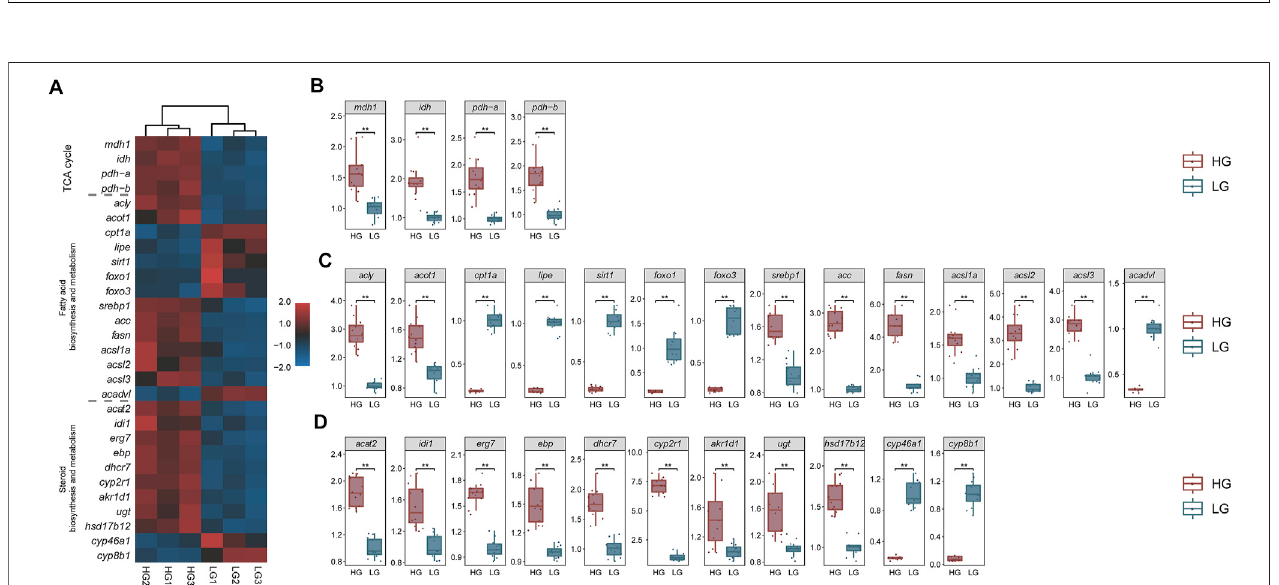
FIGURE 9 | Correlation network analysis of tilapia growth performance, differentially expressed genes (DEGs), and biochemical parameters. The colors of the nodes indicate data types, and the sizes of the nodes indicate the degree in the network. Positive and negative correlations are represented by red and green lines, respectively.